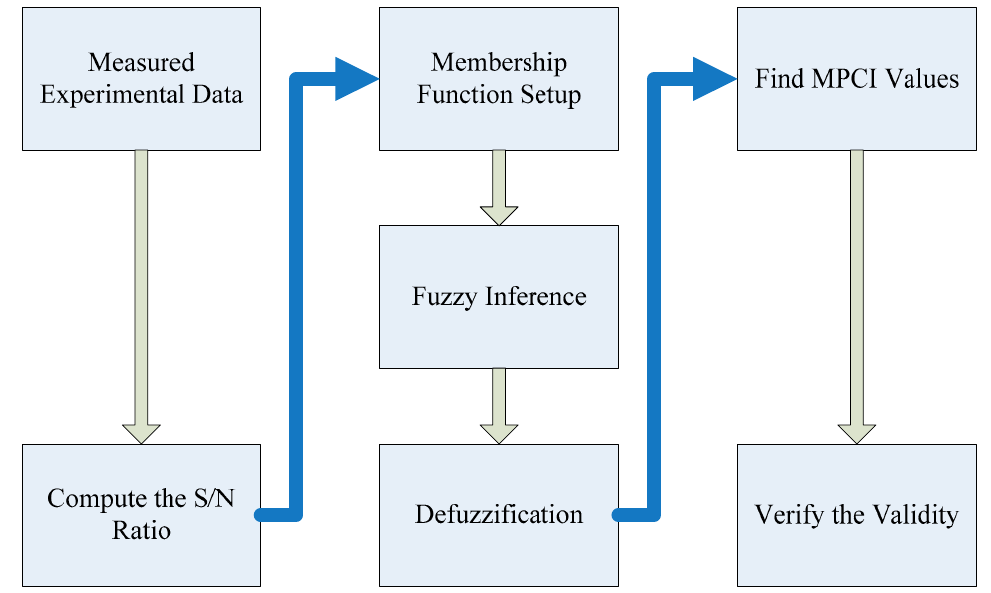
Figure 5. Flow chart of MPCI method built in cloud model.